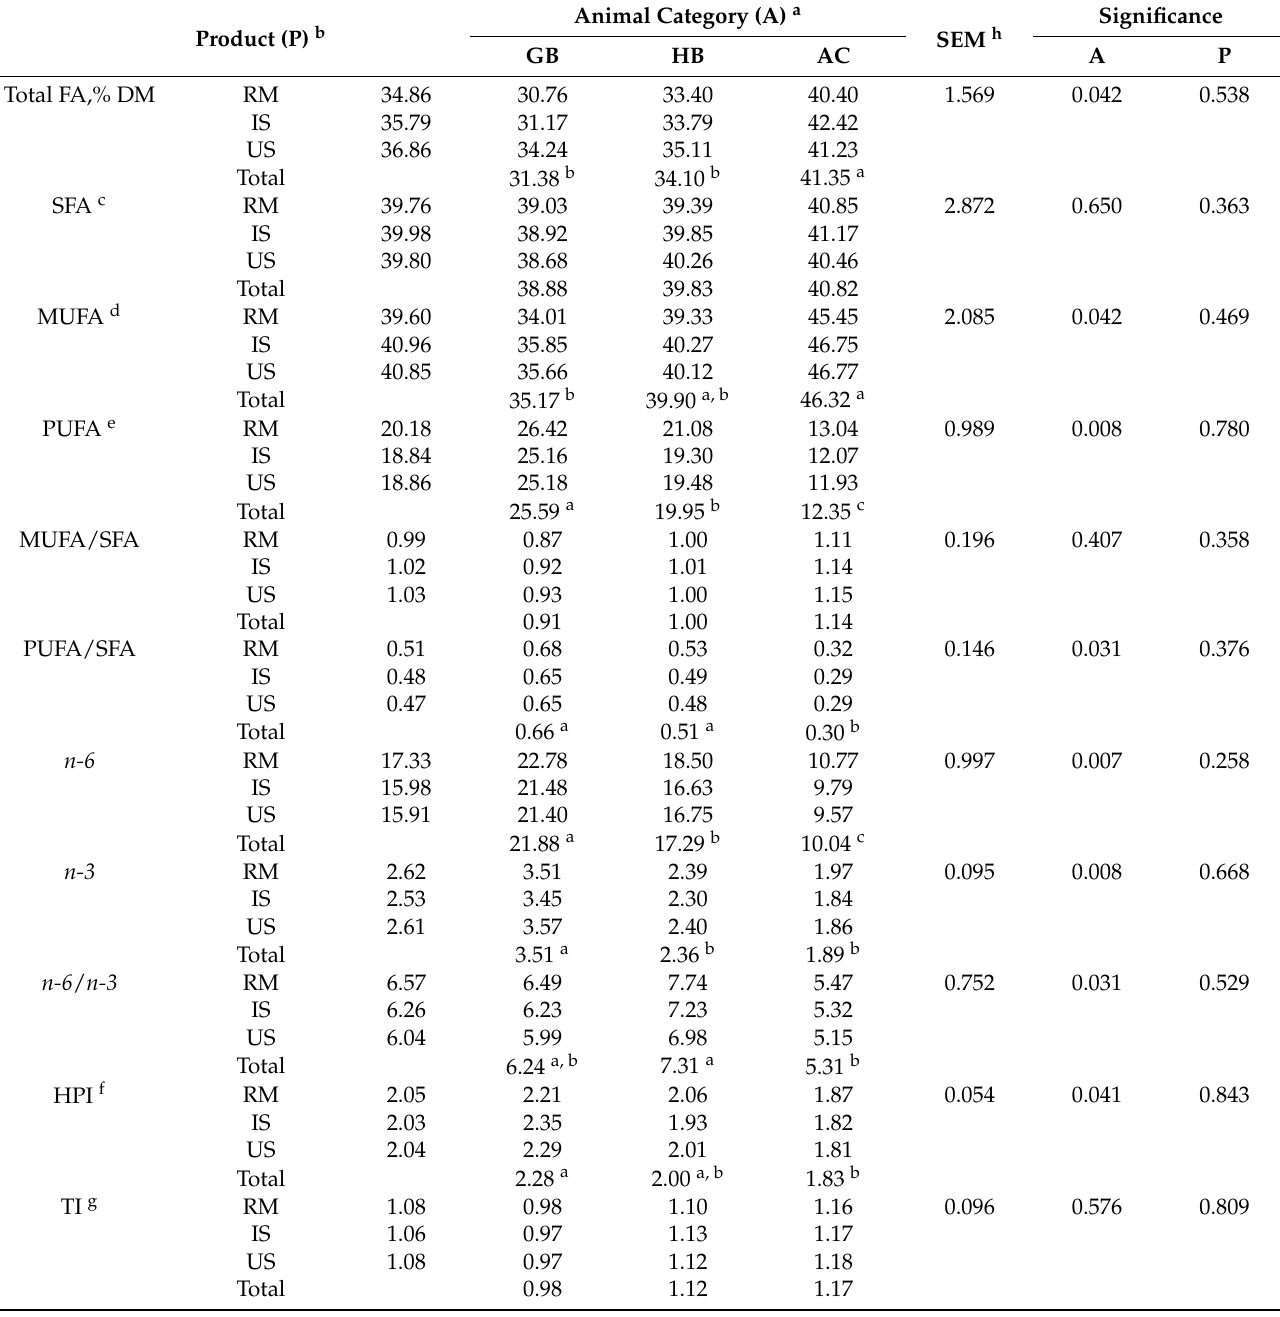
Table 2. Effects of animal category and product on fatty acids profile (% of total FA) and health indexes of salami